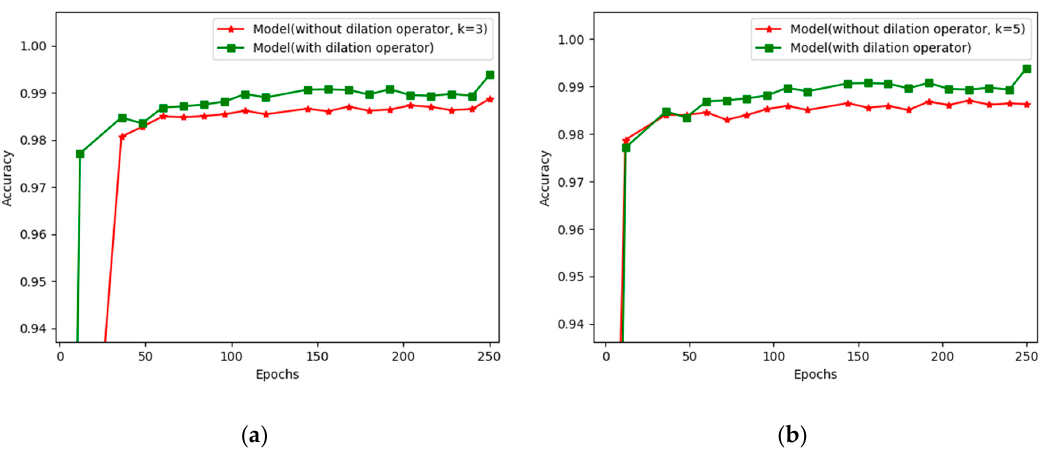
Figure 5. Comparison of training accuracies when kernel size equals ( a ) 3 and ( b ) 5, respectively. The x- and y-axes represent the number of epochs (250) and the accuracy, respectively.